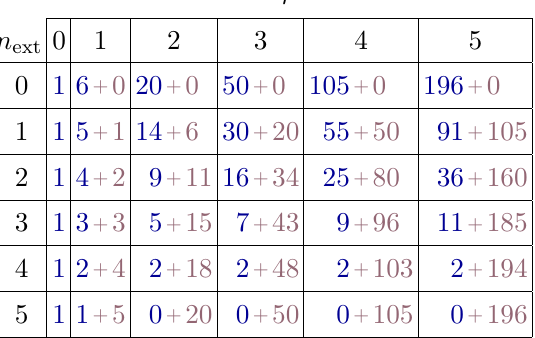
It is worthwhile to compare this approach with what is ordinarily done using OPP [110].